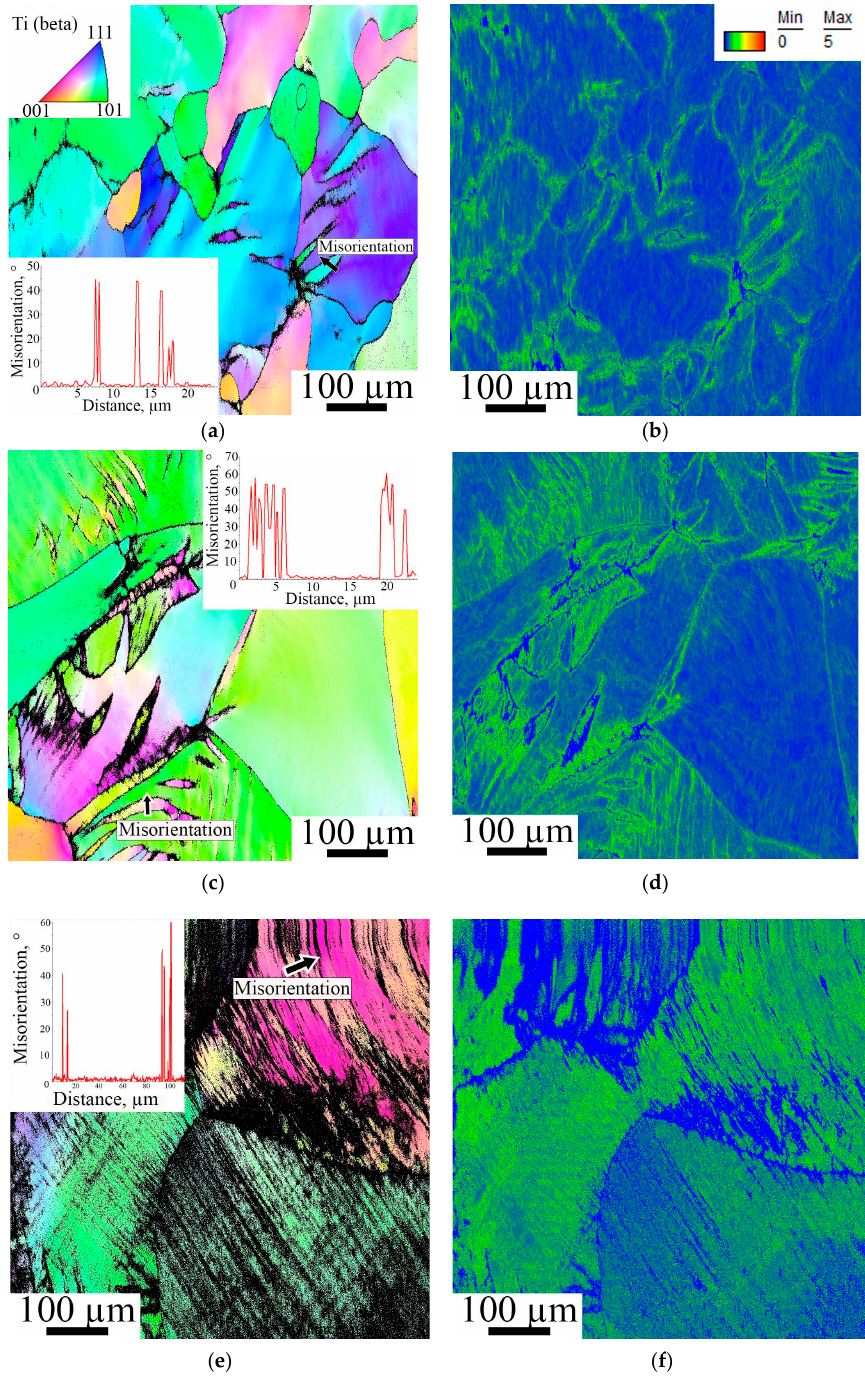
Figure 4. EBSD maps of deformed microstructures near the fracture surfaces of specimens after tensile tests; ( a , b )—Ti30Nb20, ( c , d )—Ti40Nb10, ( e , f )—Ti50Nb0; ( a , c , e )—IPF maps, ( b , d , f )—kernel average misorientation maps. Tension direction is horizontal in all cases; the fracture surfaces are located near the left side of the images.